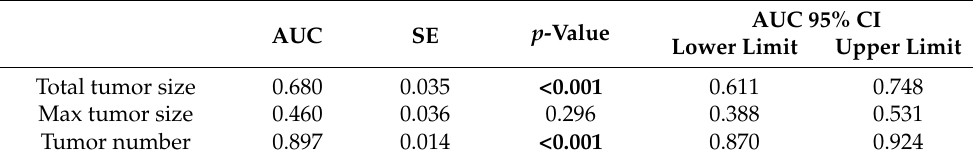
AUC = area under the curve, SE = standard error, CI = confidence interval.